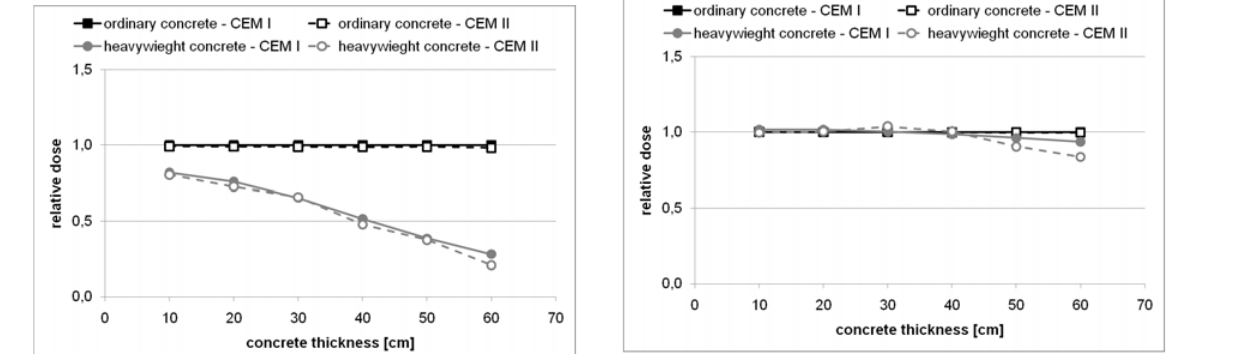
Figure 6. MCNPX simulations results for 1.0 MeV point source